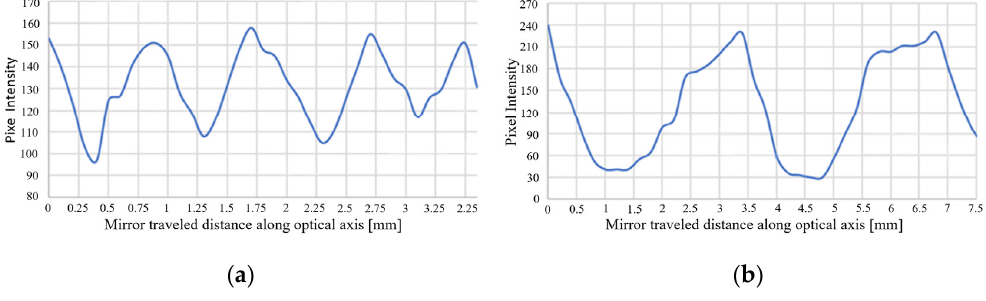
Figure 6. System pixel intensity as a function of spacing between the mirror and the PLM for ( a ) 2 pixels/period and ( b ) 4 pixels/period. (The x -axis is starting from an arbitrary position.) System throughput exhibits periodic oscillation at half of the adjacent Talbot distances.